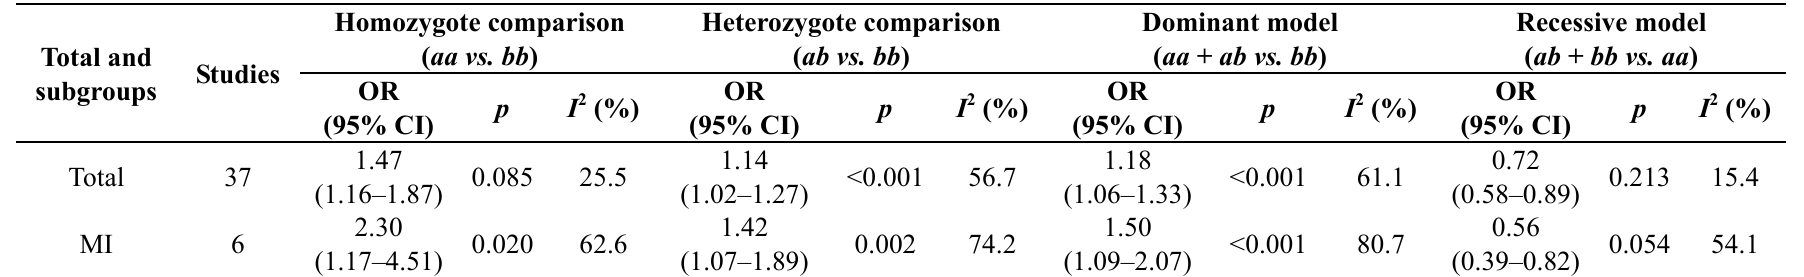
Table 2. Pooled odds ratios (OR) and 95% confidence intervals (CI) of the association between eNOS 4b/a polymorphism and CAD. Total and